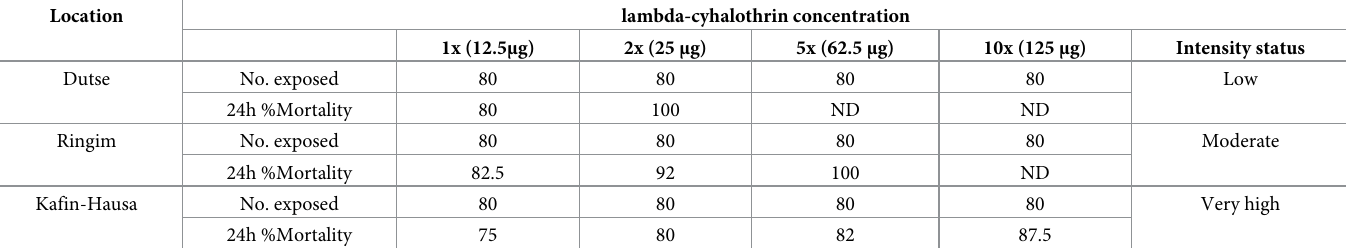
98%–100% mortality indicates susceptibility; 80%–97% mortality suggests the possibility of resistance; mortality < 80% suggests resistance. ND = Not done (This applies